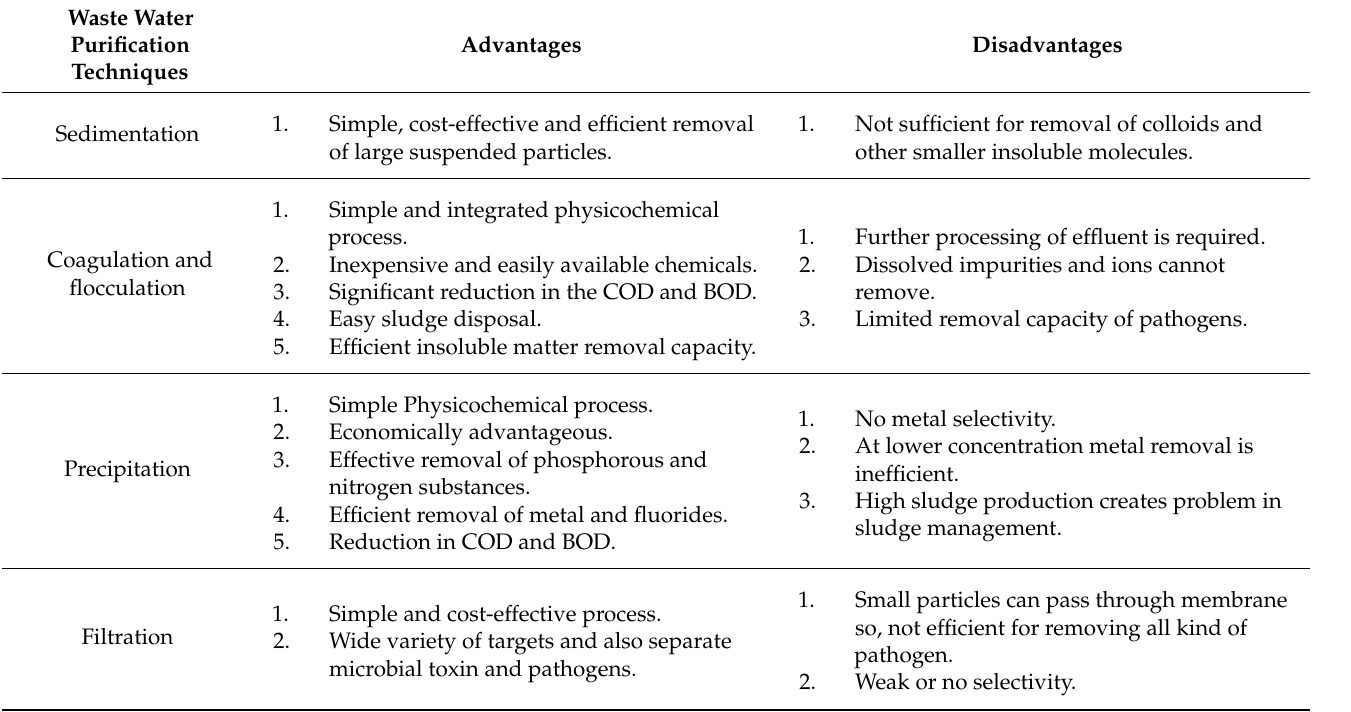
Table 3. Advantages and disadvantages of different water purification